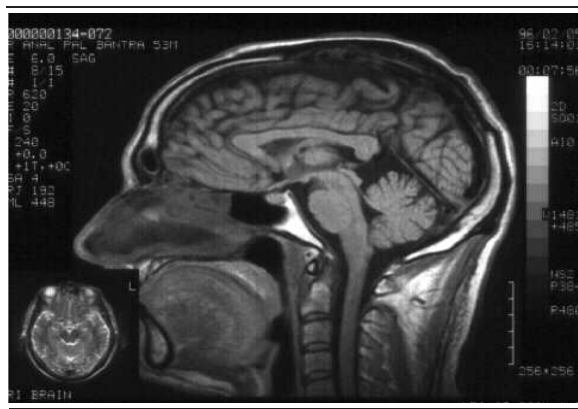
figure 2. corpus callosum in MRI scan, midsagittal section.